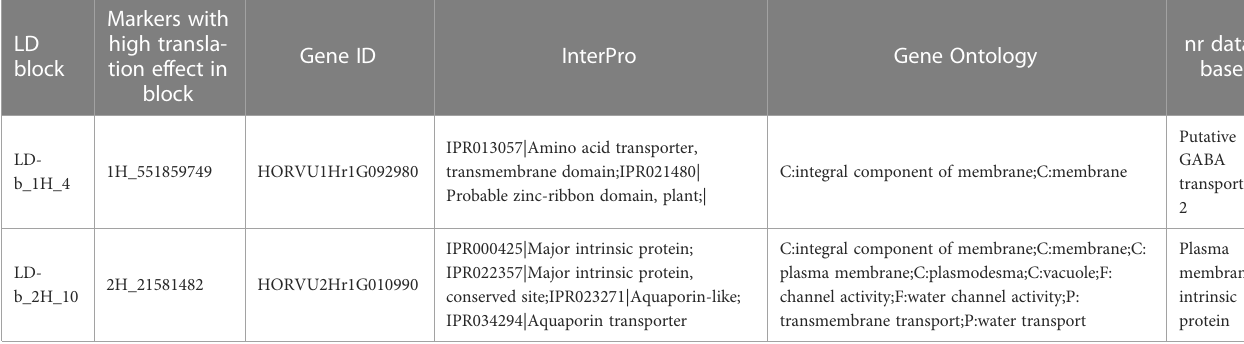
TABLE 9 Selected gene annotations for SNPs with both signi fi cant positive effects for RB and high translation effects. Markers LD block